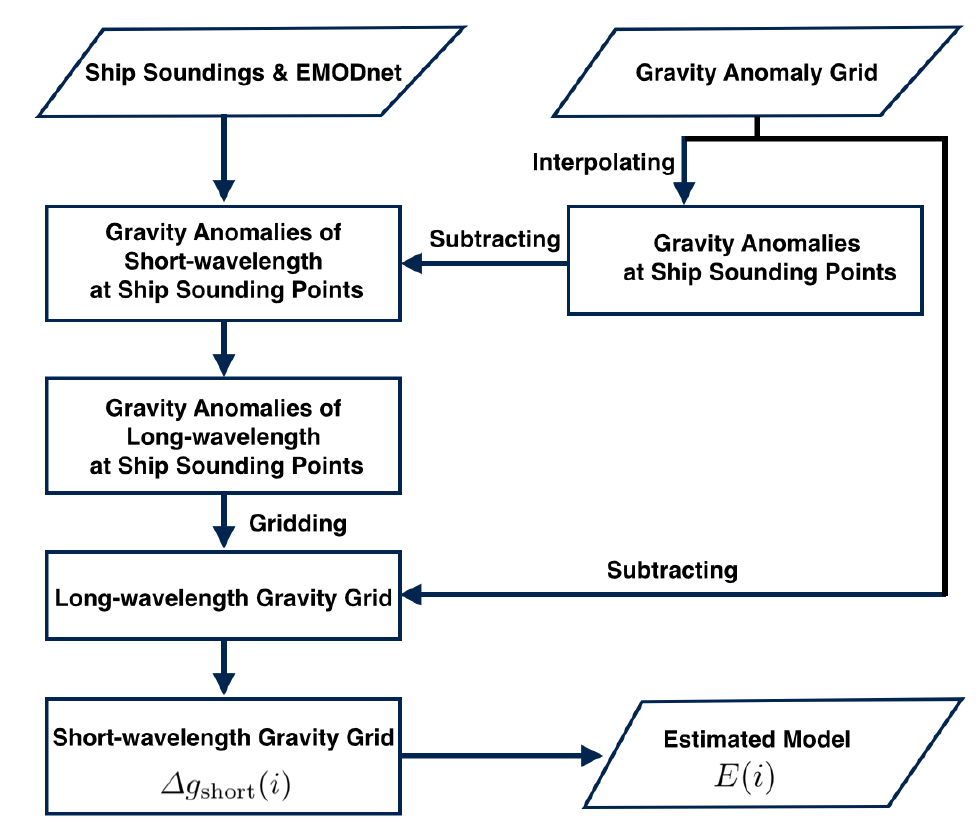
Figure 1. Flowchart of the gravity-geological